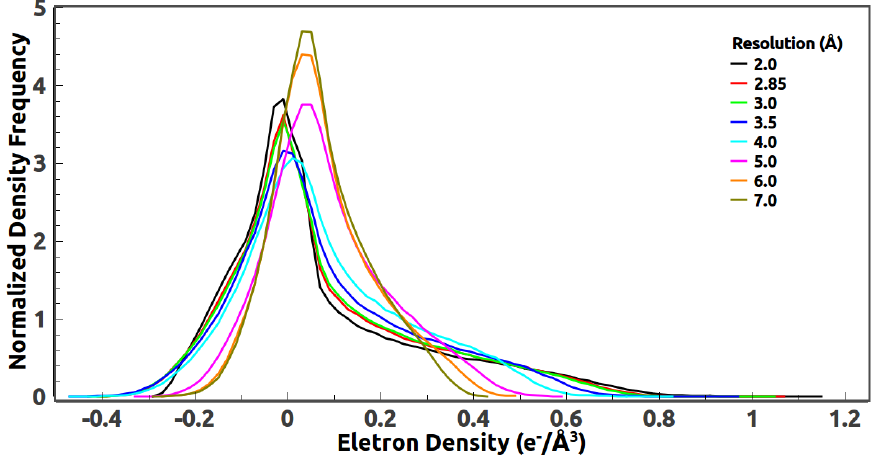
Figure 11. The density histograms of 2JLN computed from the atomic model with bulk-solvent correction, at various resolutions. For clarity, each histogram is displayed as a curve. The area under each curve equals one. All histograms have the same average